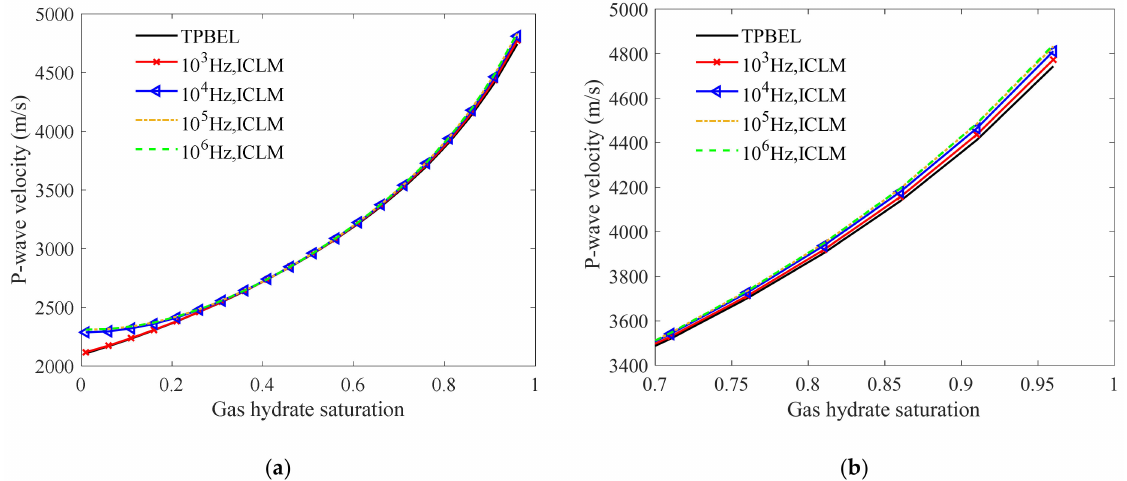
Figure A2. Variation of P-wave velocities with gas hydrate saturation in TPBEL and improved Carcione–Leclaire model (ICLM) with four frequencies: ( a ) gas hydrate saturation ranges from 0 to 1; ( b ) gas hydrate saturation ranges from 0.7 to